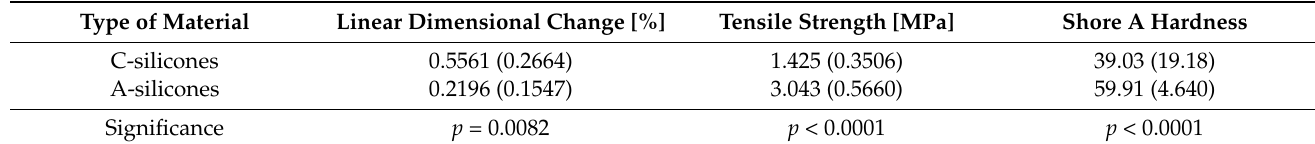
Table 2. Mean (SD) of linear dimensional change, tensile strength, and Shore A hardness for C- silicones and A-silicones, and the statistical significance ( p ) of differences between these two groups.